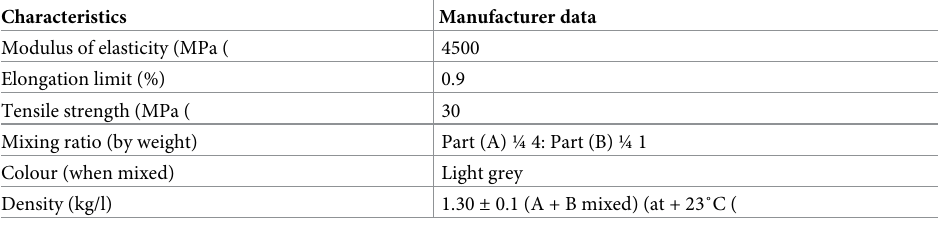
Table 8. Material characteristics of epoxy adhesive.